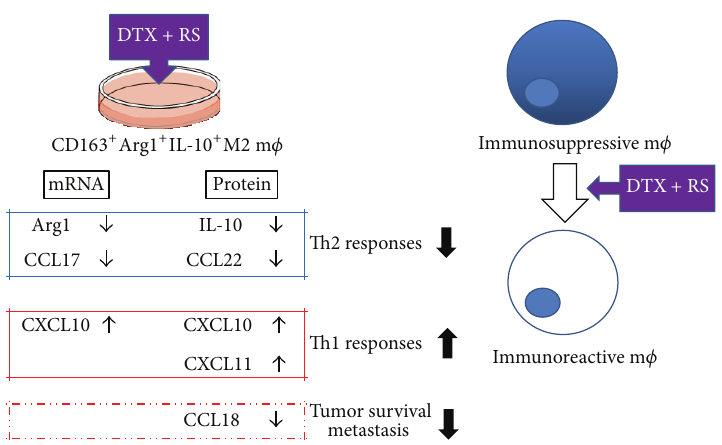
Figure 4: Schematic representation of immunomodulatory effect of DTX and RS together with DTX. RS modulates the chemokines and cytokines from M2 macrophages, and induces an antitumor immune response in the tumor